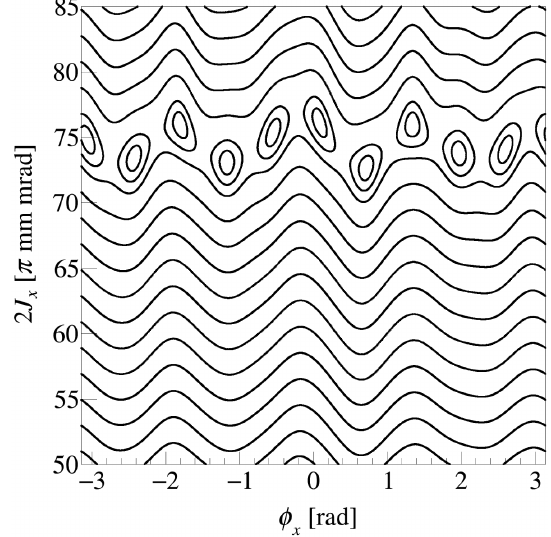
FIG. 14. Simulated Poincar´e map in the horizontal plane with the new optics. The vertical action was set to J y ¼ 0